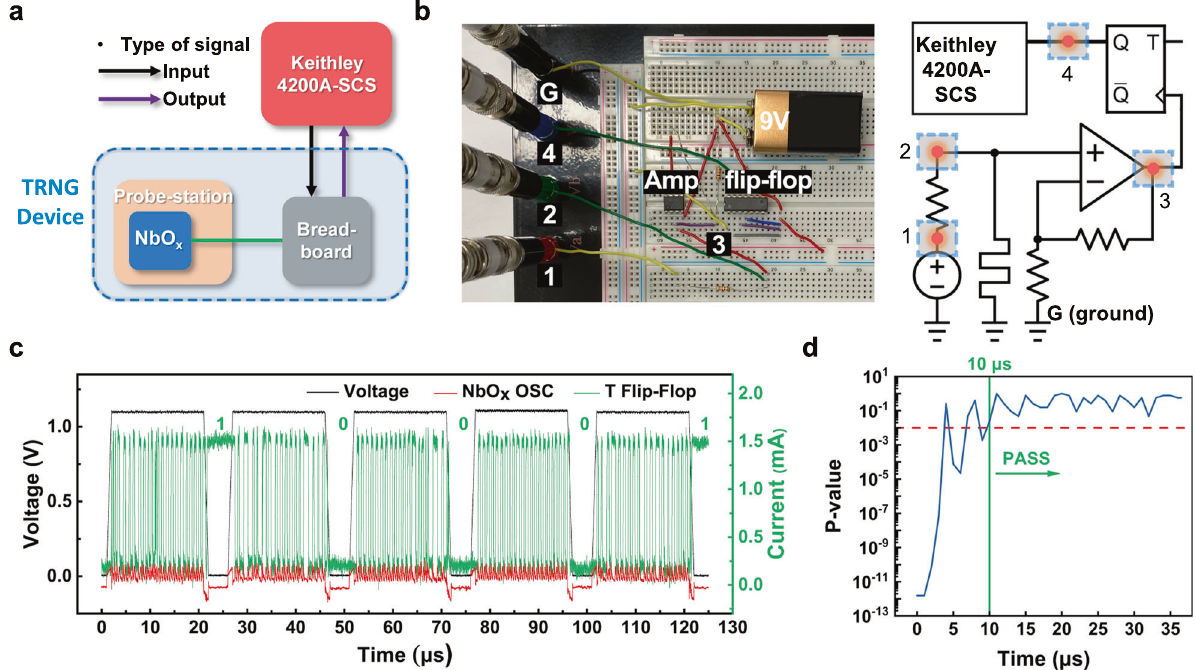
Fig. 4 Experimental demonstration of the TRNG. a An operating scheme of the proposed TRNG in experiments. b A photograph of the circuit built on a breadboard (left) and a circuit layout (right). c A demonstration of the random bit generation for six consecutive cycles. A black, red, and green lines show the input pulse voltage, the oscillation current, and the output current of the T fl ip- fl op, respectively. d A P value of the monobit test as a function of the input voltage pulse time. Above the P value of 0.01 (red dashed line), it is regarded as random numbers. After 10 μ s of pulse time, the outputs become true random numbers.